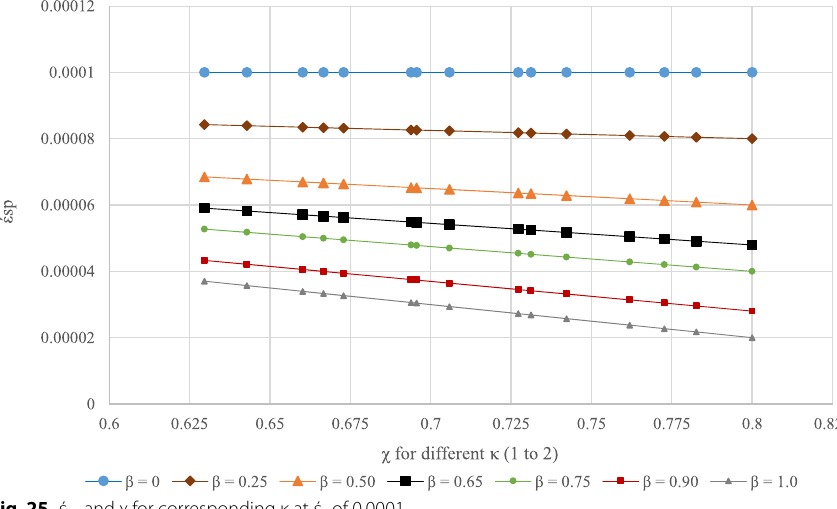
Fig. 25 έ sp and χ for corresponding κ at έ y of